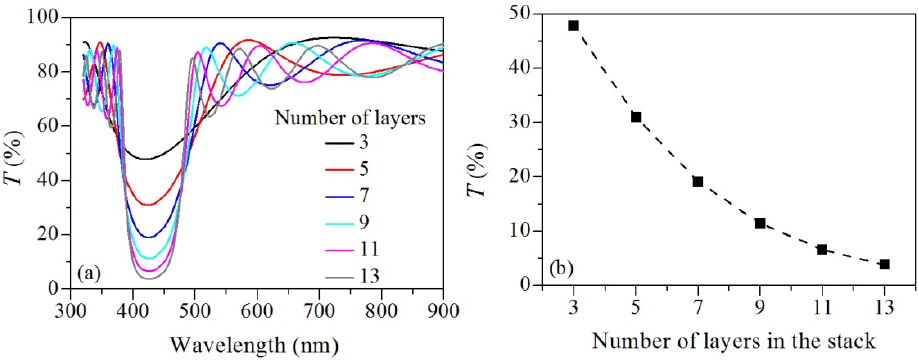
Figure 3. Transmittance spectra of modeled Bragg stacks ( a ) and stop band intensity as a function of number of the layers in the stacks ( b ).